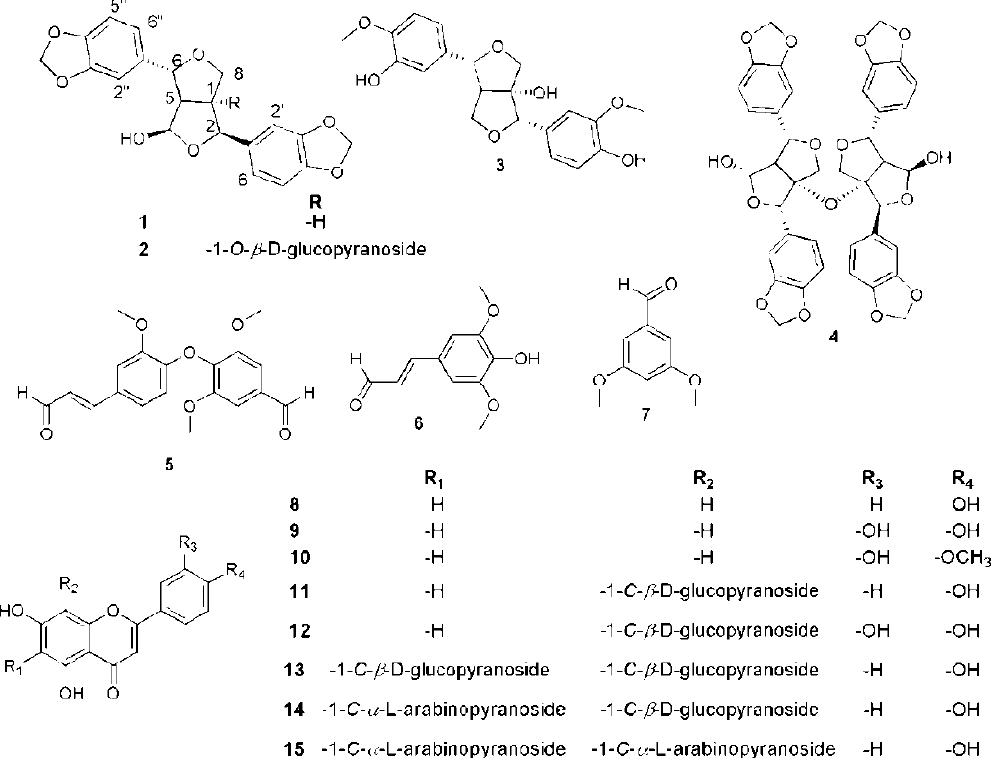
Figure 2. Structures of compounds isolated from the Premna odorata bark.